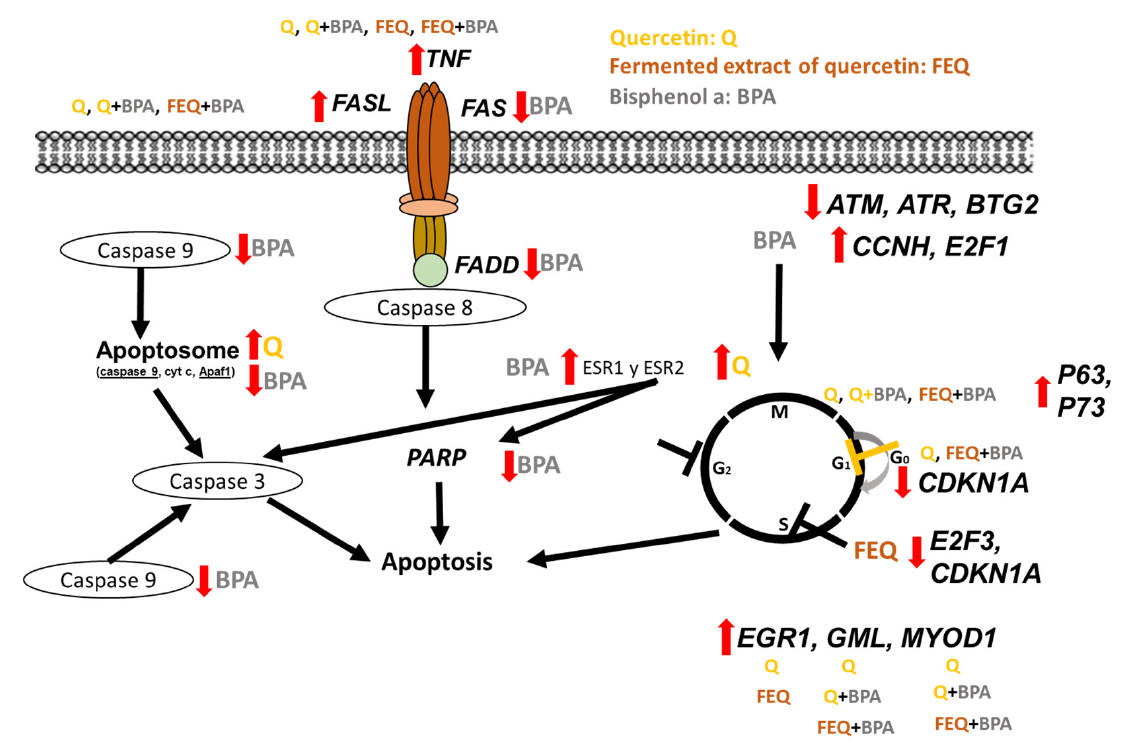
Figure 9. Proposed mechanism of action that explains how Q, FEQ, Q+BPA and FEQ+BPA promote cell inhibition, avoiding the effect of BPA on HT-29 cells. Yellow letters indicate processes carried out by Q, in brown FEQ, and in gray BPA. Red arrows pointing upwards indicate positive regulation and down arrows indicate negative regulation. The highlighted black words correspond to the results found in this study.